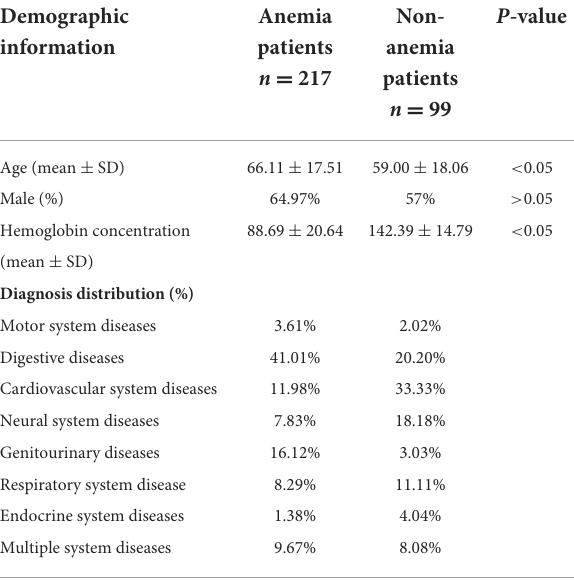
TABLE 1 Demographic information of the patients in the